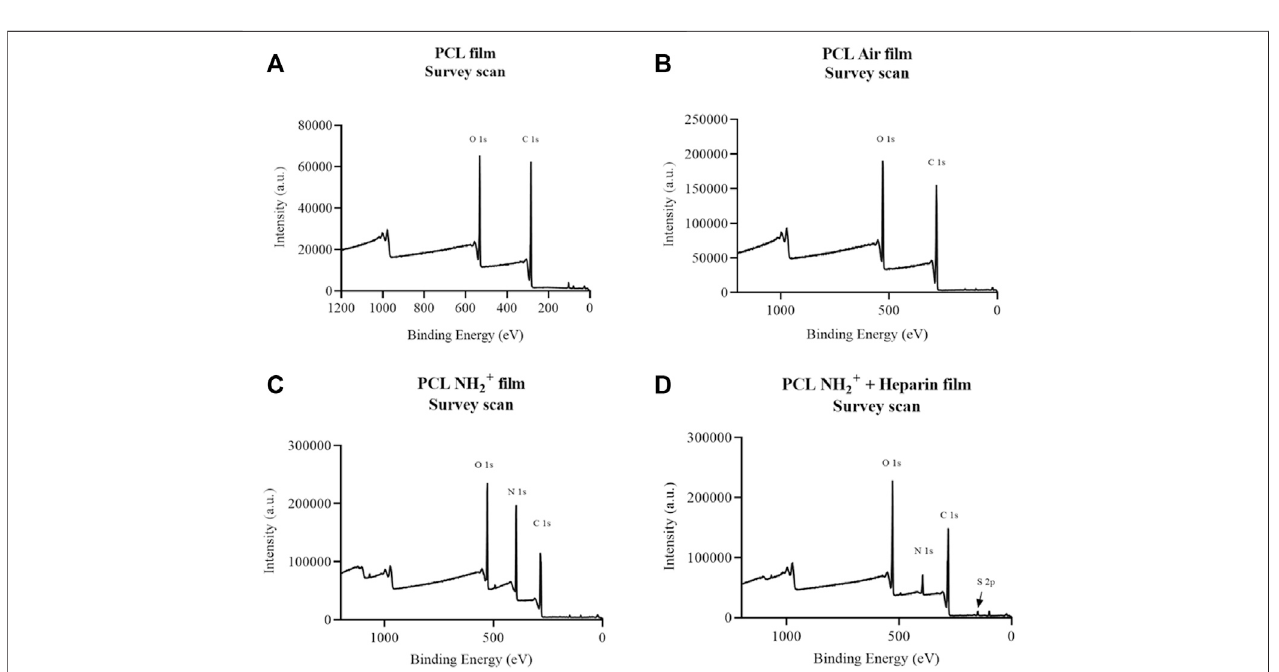
FIGURE 2 | XPS survey scans of (A) PCL scaffold; (B) PCL air treated scaffold (PCL Air scaffold); (C) PCL + NH 2+ scaffold; (D) PCL+ NH 2+ + Heparin scaffold. Carbon was detected at 285 eV, oxygen at 532 eV, nitrogen at 400 eV, and sulphur at 168